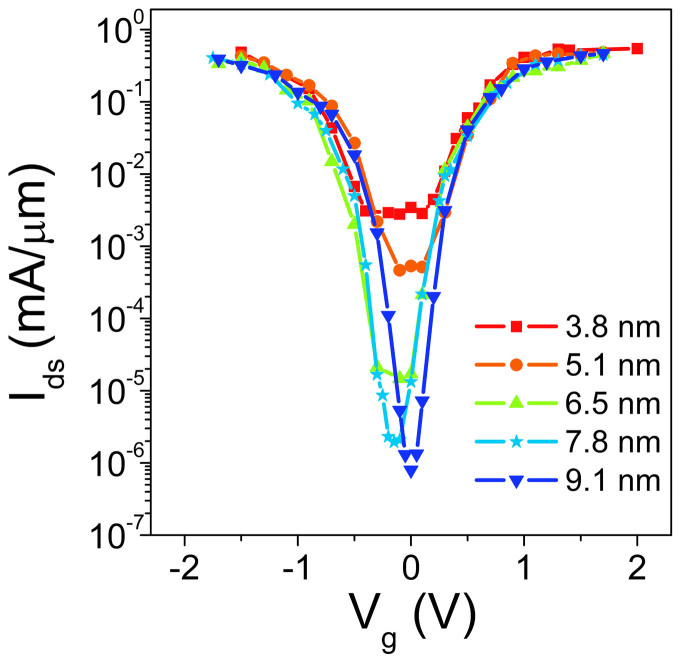
Transfer characteristics of the SNM FETs for different channel lengths at Vbias = 0.2 V.